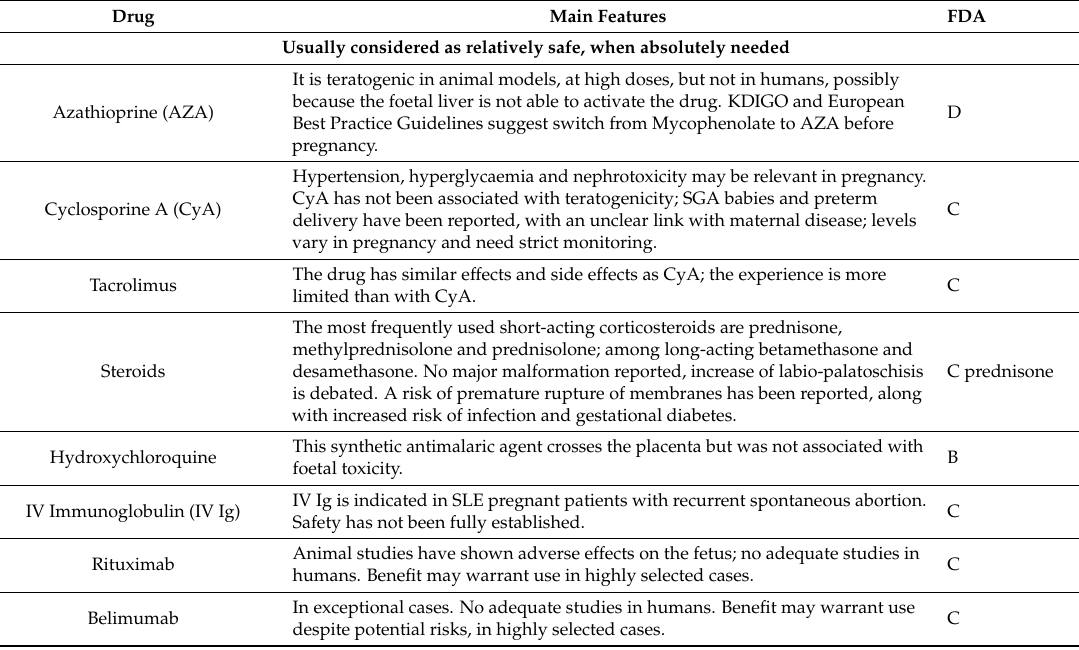
Table A1. Main immunosuppressive drugs for CKD patients in pregnancy. Main